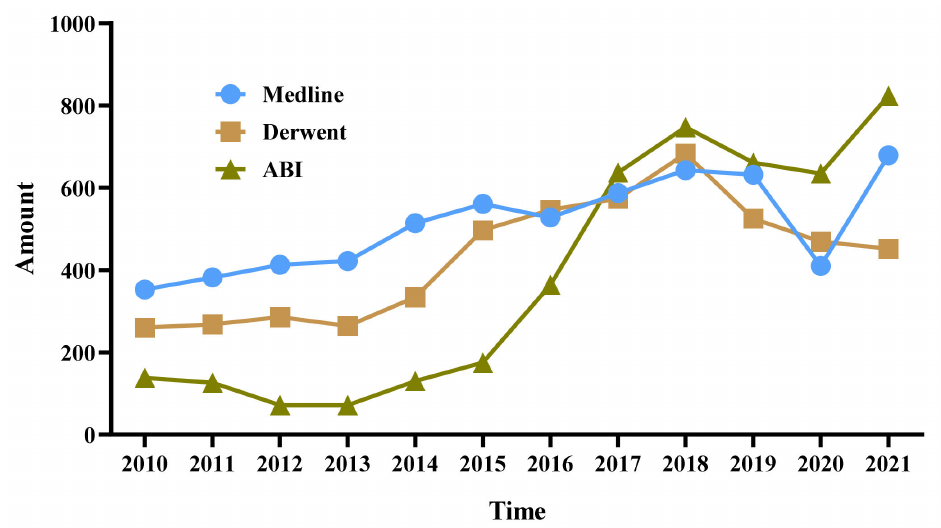
Figure 4. Statistical results of papers, patents, and commercial data related to hyperuricemia